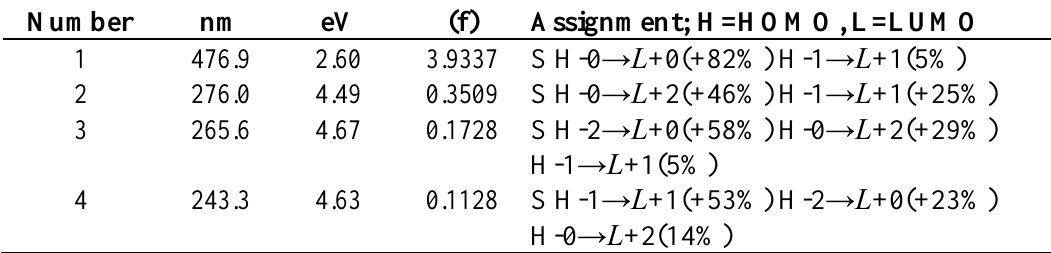
Table 3. Electronic transition states of norbixin (nm, eV, oscillator strengths (f), and transition assign-ments as calculated with TD-DFT and the M05-2X/6-31+G(d,p) level of theory. Only the transition states with f > 0.02 are